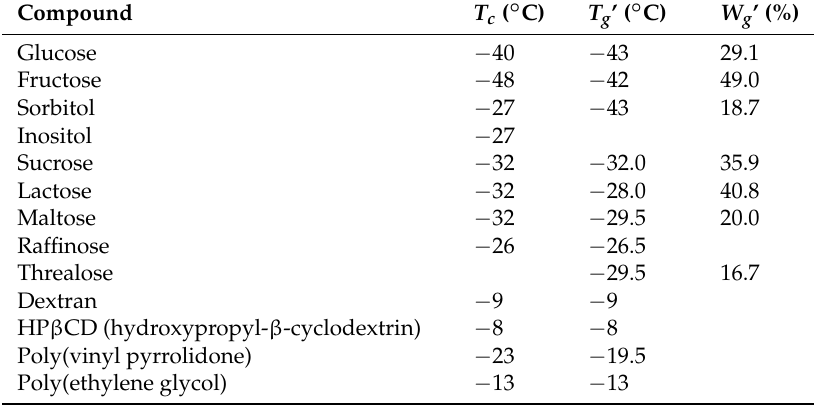
Table 3. Collapse temperature ( T c ), glass transition temperature of maximum freeze concentrate ( T g ’) and water content remaining within an amorphous phase ( W g ’) of various solutes (adapted from [75]).